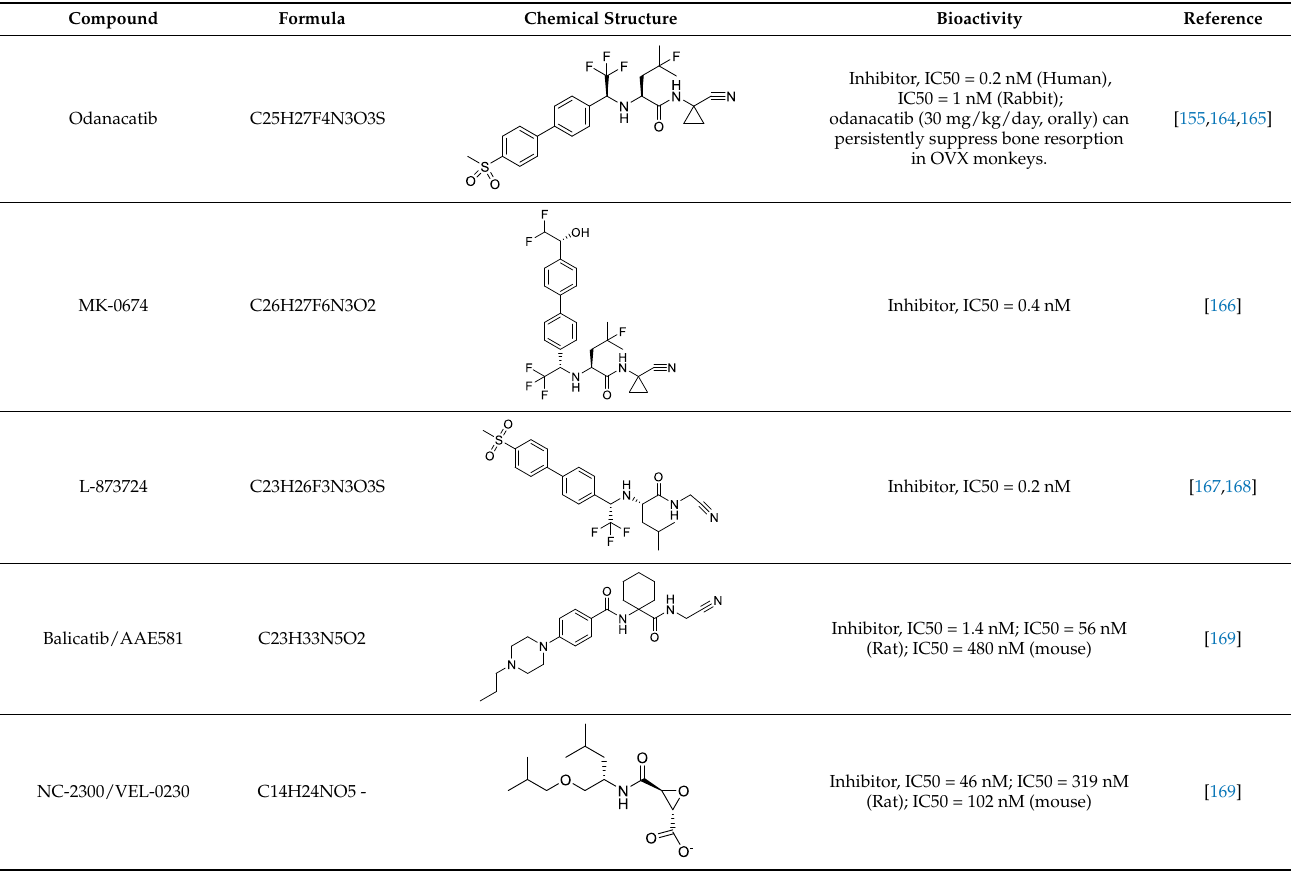
Table 2. The reported potential inhibitors of CTSK.